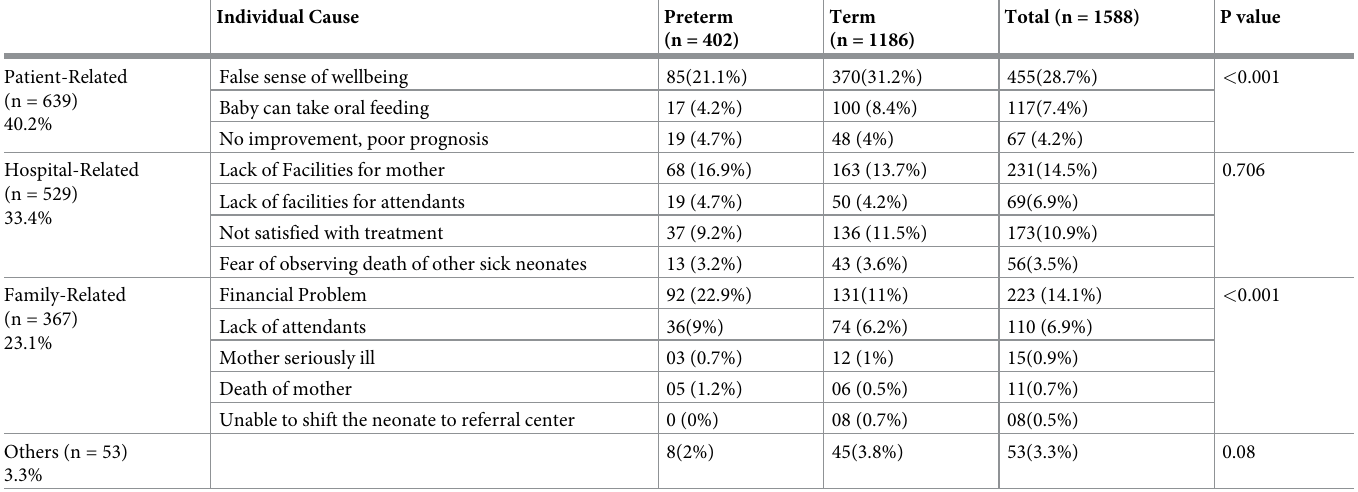
Table 3. Cause behind DAMA according to care-givers’